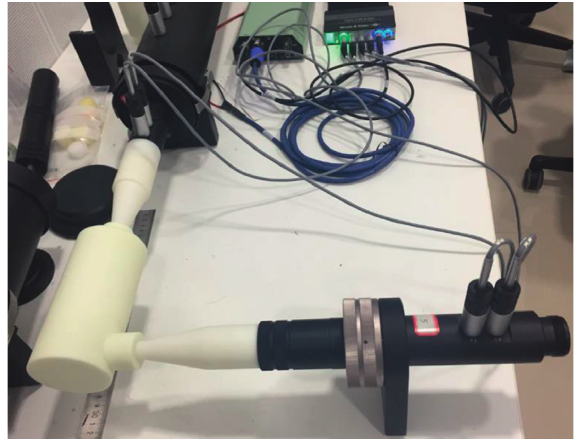
Figure 13: Photo of the experimental setup for testing the transmission loss of the side outlet